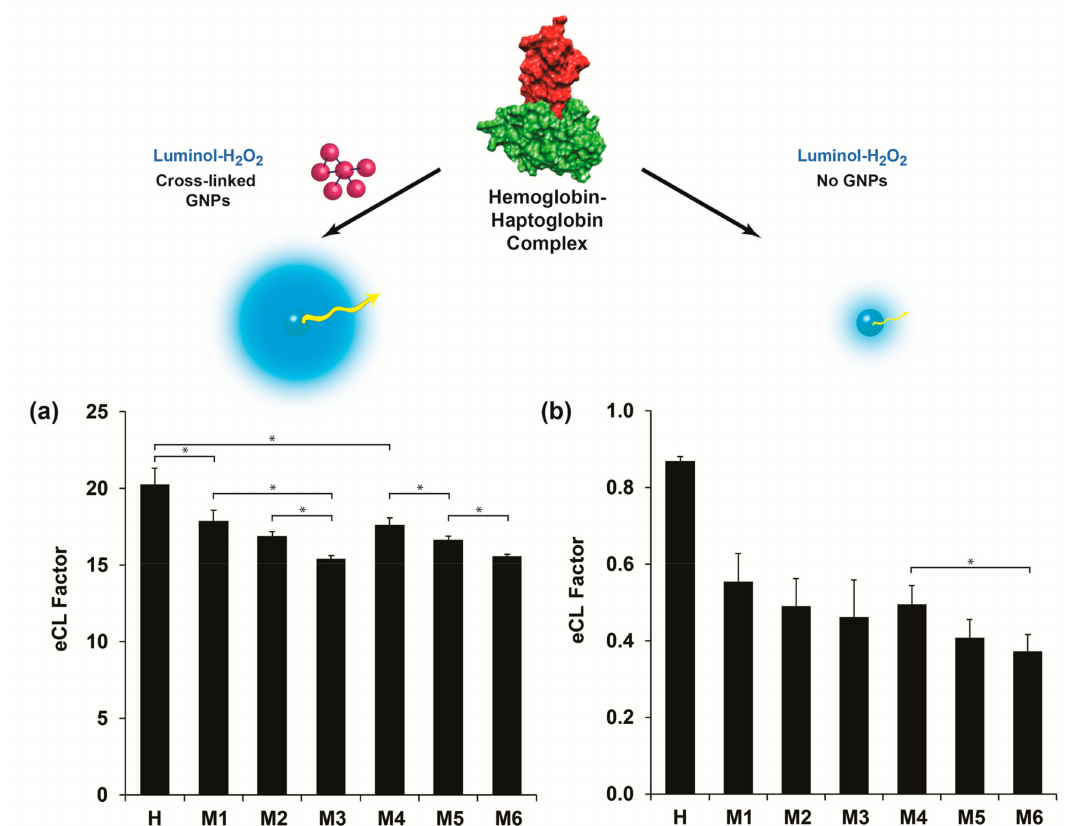
Figure 5. Enhanced CL factor for the analyzed milk samples: ( a ) With and ( b ) in the absence of 25 nm cross-linked GNPs onto the luminol CL system. Top inset: A schematic illustration of the intensified emitted radiation (eCL concept). The enhancement values were calculated with respect to CL values in the absence of cross-linked GNPs, while omitting milk from the assay. Data are reported as mean ± standard deviation ( n ≥ 3). * Significantly di ff erent (t-test, p < 0.05).